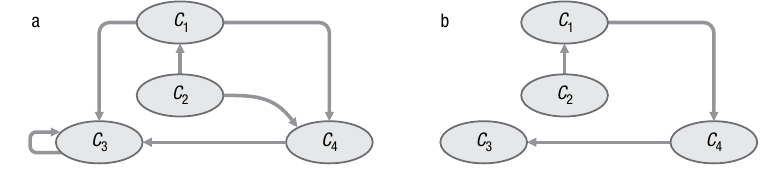
Fig. 2. Structures of two